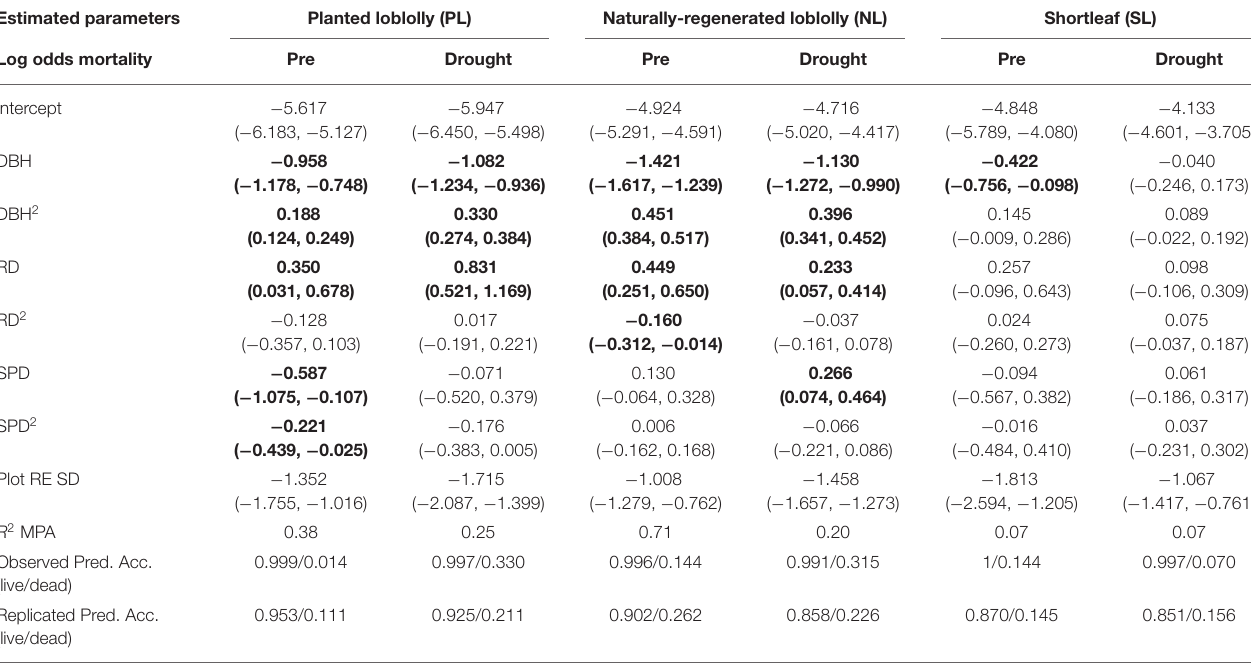
TABLE 2 | Model results for the effects of stand structure on pine group mortality for each measurement period with 95% credible intervals (DBH, diameter at breast height; RD, plot relative density; SPD, plot species dominance; Plot RE SD, estimated standard deviation from the random effect of plots). Estimated